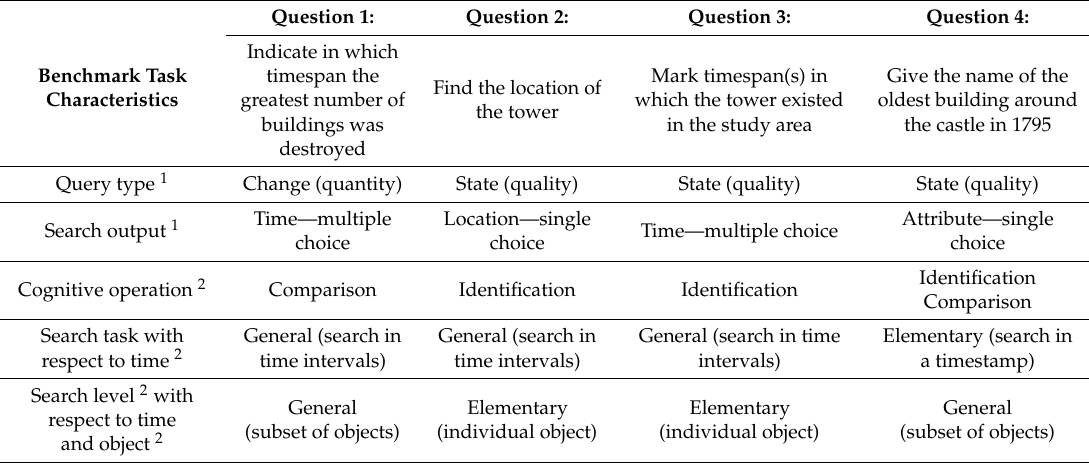
Table 1. Benchmark tasks to assess the usability of spatiotemporal visualizations: the slider-based visualization and the space–time cube.